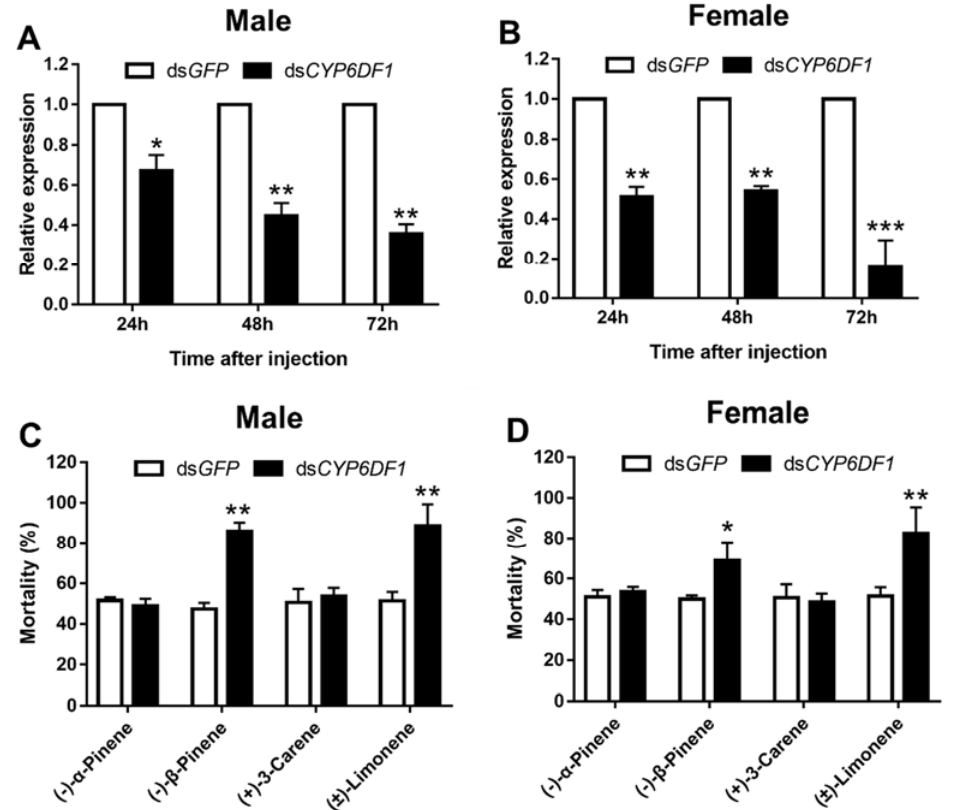
Figure 7. ( A , B ) Relative expression levels of DaCYP6DF1 in adults injected with dsRNA at 24, 48, and 72 h post-injection. ( C , D ) The mortality of adults exposed to four terpenoids was assessed at 48 h after dsRNA injection. The relative expression levels were normalized with β -actin and CYP4G55 . The asterisk indicates a significant difference between treatment groups (* p < 0.05, ** p < 0.01, *** p < 0.001, independent Student’s Test). All values are mean ± SE , n = 3.